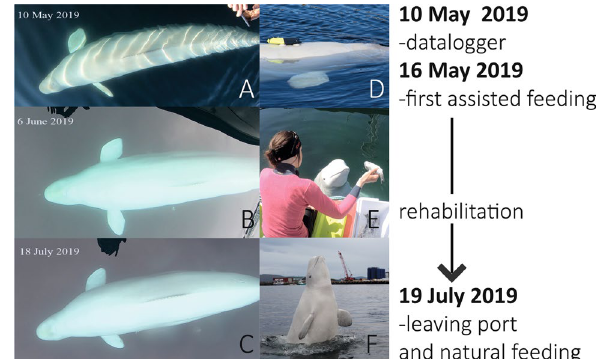
Figure 1. Pictures of beluga whale ‘Hvaldimir’ in summer 2019; ( A – C ) Photos show observations of his body condition when at Hammerfest between May and July 2019; ( D ) with the back-mounted, suction cup attached GoPro video camera used to record foraging behavior; ( E ) being hand-fed herring during a routine feeding session; and ( F ) in the harbor of Hammerfest, northern Norway, in July 2019, playful and seeking human